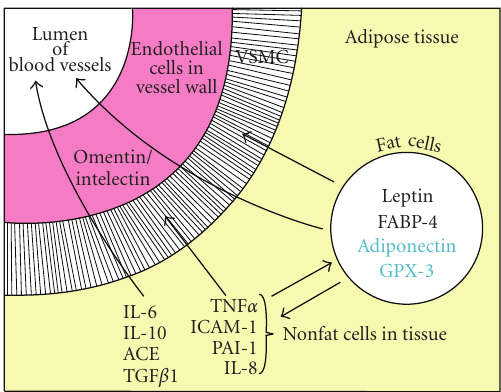
Figure 5: The relationship between adipokine release and paracrine signaling in human adipose tissue. The adipokines are divided into those released by fat cells [leptin, FABP-4, adiponectin, and GPX-3] and those by nonfat cells in adipose tissue [IL-6, IL-8, IL- 10, ACE, PAI-1, ICAM-1, TNF α , TGF β 1, and omentin/intelectin]. Adipokines shown in black are those whose circulating levels are elevated in obesity as well as their release by incubated human adipose tissue explants. Circulating levels of adiponectin and GPX- 3 are shown in blue since they are not elevated in obesity. Omentin/intelectin is shown as being secreted by the endothelial cells of the blood vessels of omental but not subcutaneous fat [108]. The arrows depict possible targets of the adipokines as the other cells in adipose tissue, as well as vascular smooth muscle cells (VSMC) and endothelial cells in the blood vessel walls plus release into the circulation (lumen of blood